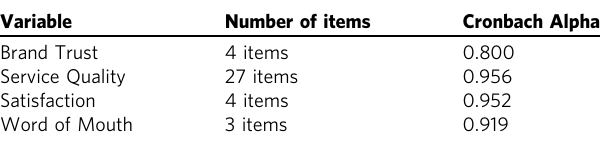
Table 1 Reliability value of each construct after pilot